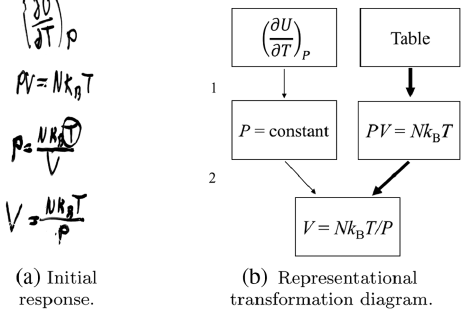
FIG. 12. Student 3 ’ s unproductive analytical derivation strat- egy. He invoked the ideal gas law and rearranged